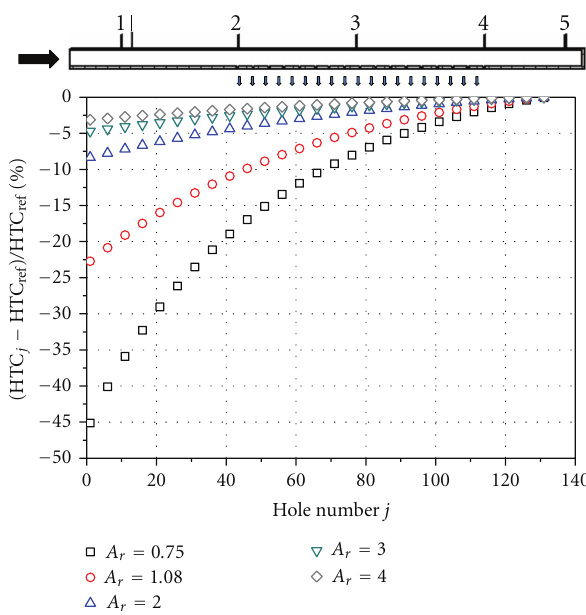
Figure 12: Mean heat transfer coe ffi cient distribution varying the A r parameter, β = 1 . 05.